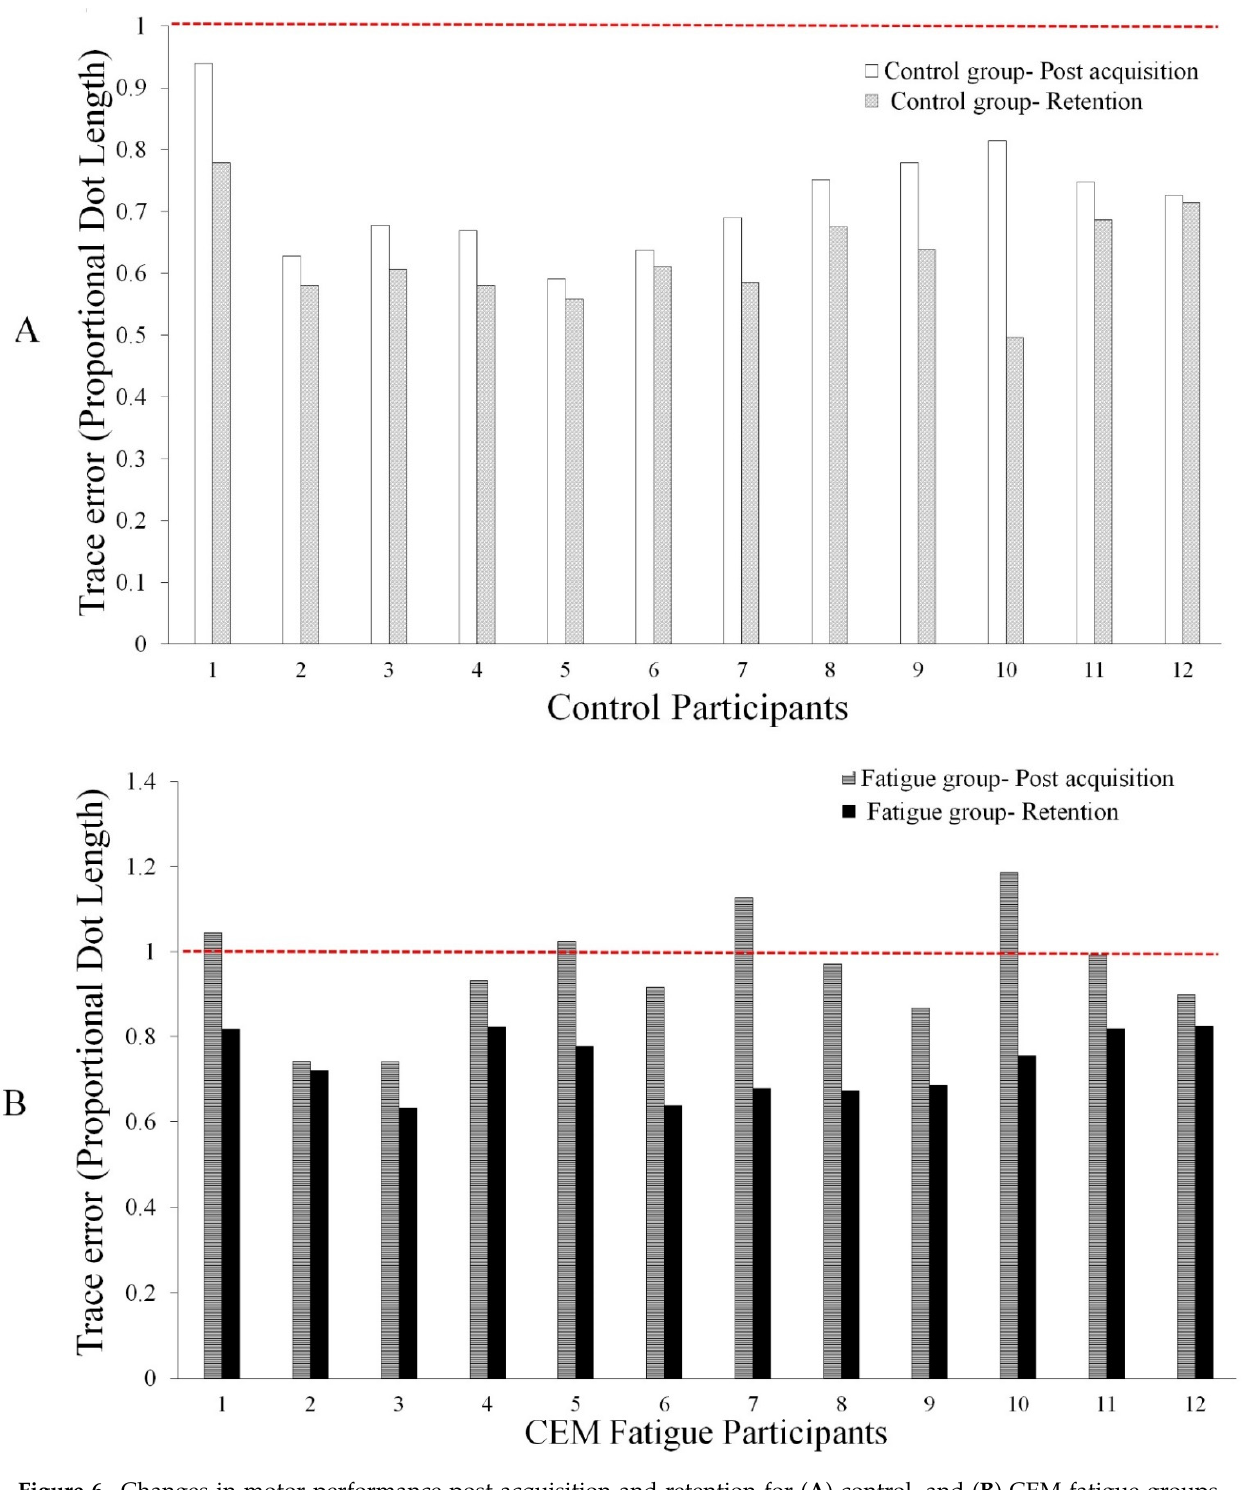
Figure 6. Changes in motor performance post-acquisition and retention for ( A ) control, and ( B ) CEM fatigue groups. Individual performance change shown relative to normalized pre acquisition performance (dotted red line). The control group demonstrated a greater improvement post acquisition ( p = 0.0001) and at retention ( p = 0.002) than the fatigue group.